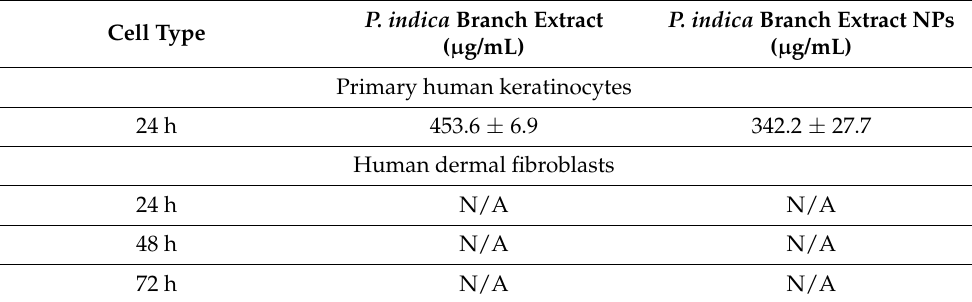
Figure 4. Effect of P. indica branch extract and NPs on primary epidermal keratinocyte cell viability after incubation for 24 h. The data represent mean ± SD of three experiments. Table 1. IC 50 values of P. indica branch extract and